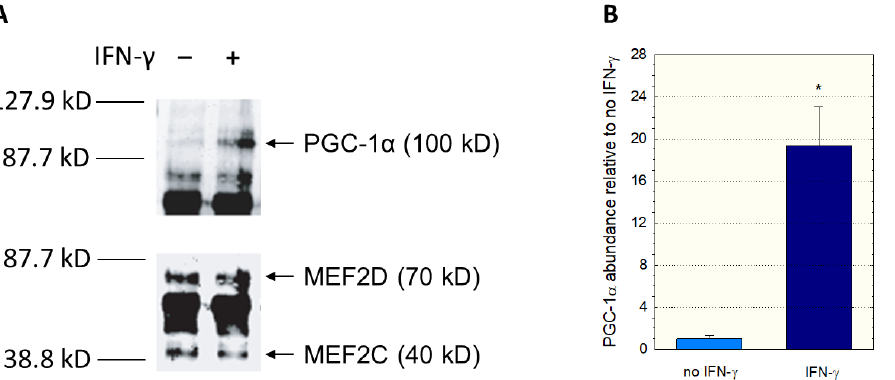
Figure 5. Interaction between PGC1 α and MEF2. C2C12 myoblast lysates were incubated with anti-MEF2 antibodies, and the separated precipitates assayed using anti-MEF2 and anti-PGC-1 α antibodies. The corresponding immunoblots are shown in ( A ) and the quantification of the PGC-1 α band in ( B ). Treatment of C2C12 myoblasts with interferon- γ was performed for 12 h. Interferon - γ activates the p38 MAP kinase (p38 MAPK), which activates MEF2. Data are presented as the mean ± SD of n = 3 independent observations. * p < 0.05 vs. incubations without IFN- γ.